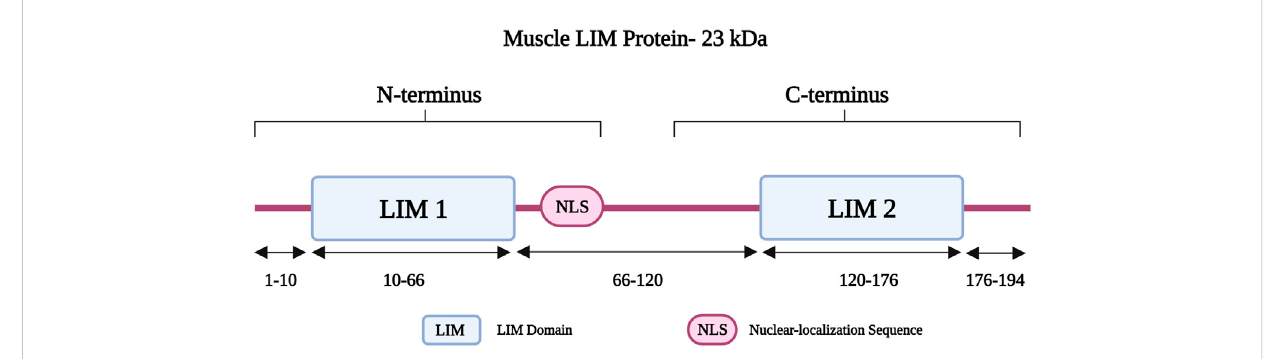
FIGURE 5 Schematic representation of the muscle LIM protein regions with different residues in the two LIM domains and the Nuclear-localization Sequence (NLS). Created with BioRender.com. Adapted from (Chauhan and Sowdhamini,